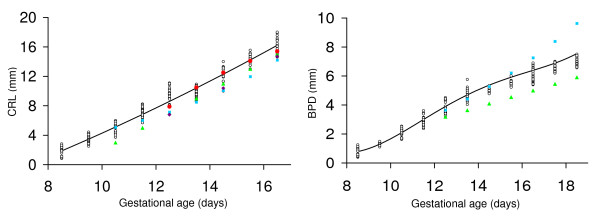
Comparison of crown-rump length and biparietal diameter measurements with prior work. Crown-rump length (CRL) and biparietal diameter (BPD) are shown as a function of gestational age. Open symbols show the results obtained for each conceptus in the current study. The solid lines were generated using the regression equations shown in Table 1. Solid symbols show results from prior work. Values were calculated using formulas for CD-1 embryos obtained using 7.5–10 MHz (blue squares; [17]) or 15 MHz (green triangles; [16]) ultrasound or are means reported in Tables for C57Bl/6 embryos (red circles [18], purple diamonds [15]).